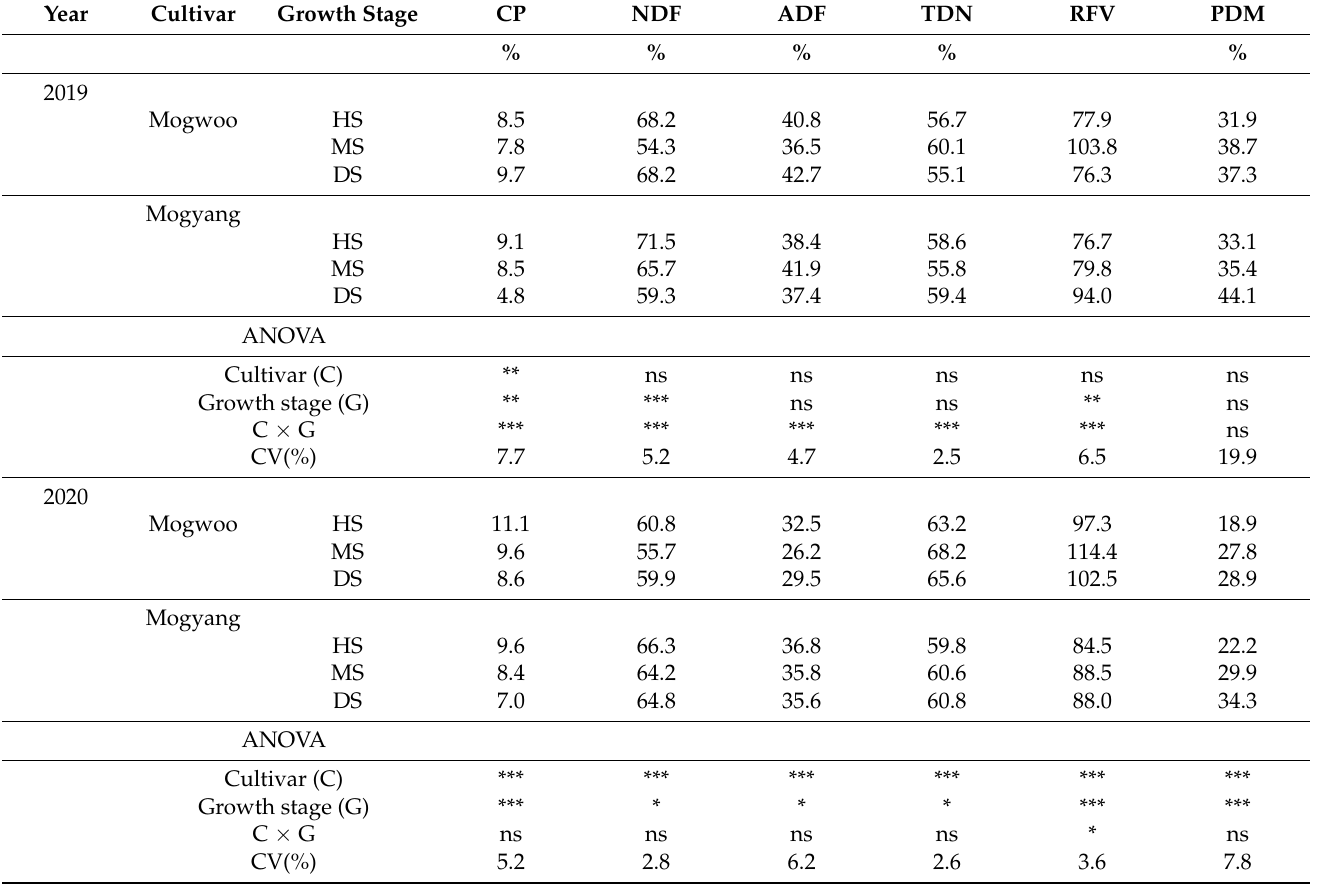
Table 5. The chemical composition according to the growth stage of ‘Mogwoo’ and ‘Mogyang’ during the two years’